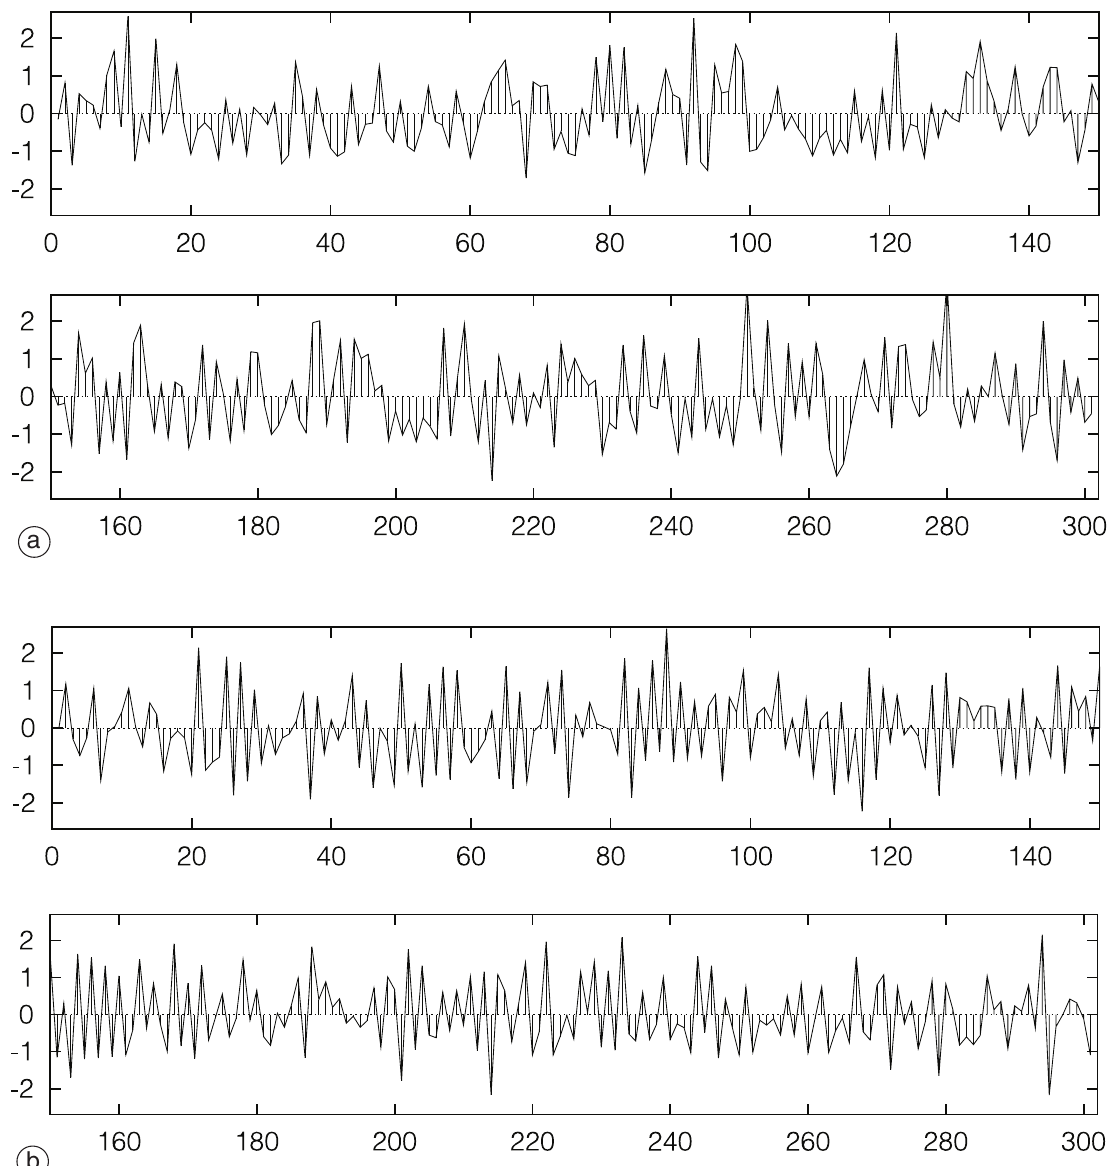
Fig. 7a,b. Standardised time series for the patterns in fig. 5a,b. a) For Atlantic/European MSLP; b) for tropical SST. Correlation coefficient between time series is